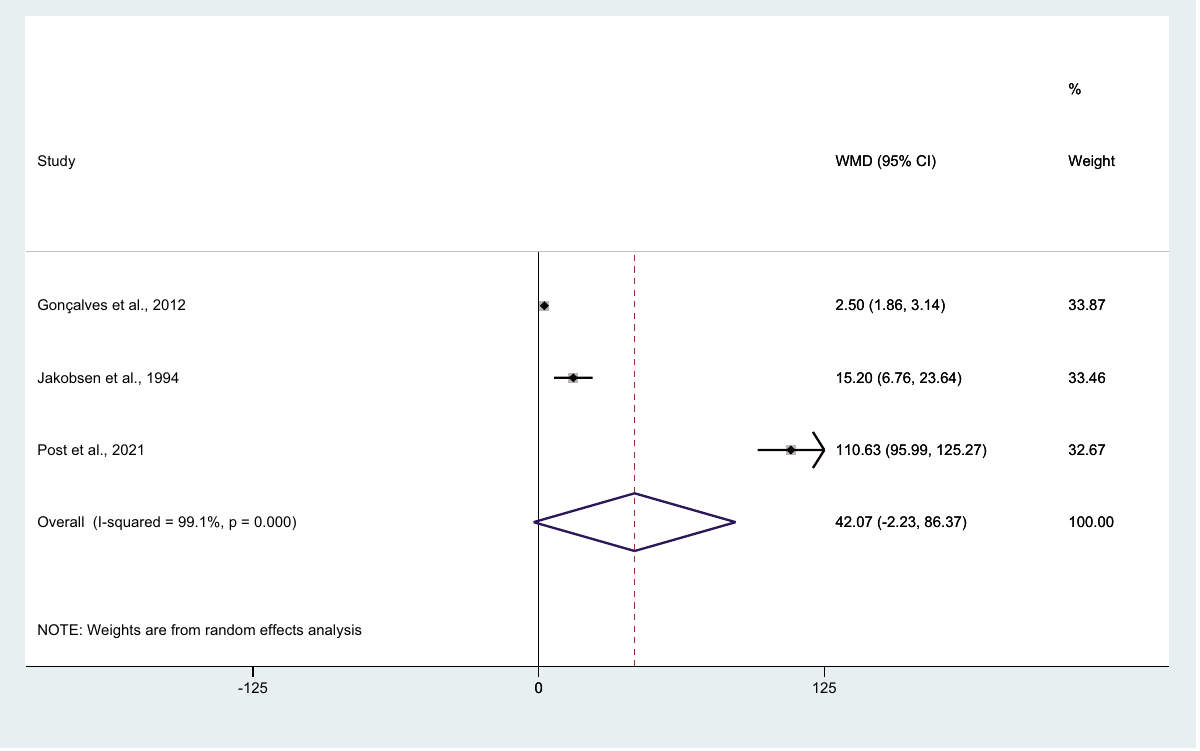
Figure 13. Differences in IL-6 levels between patients with uncomplicated malaria and asymptomatic malaria. Abbreviation: WMD, weighted mean difference; CI, confidence interval; black diamond symbol, point estimate; solid line in the middle of the graph at 0, zero effect size; Dashed red line: pooled WMD between the two groups; I 2 , level of heterogeneity; P = 0.000 or less than 0.05, significant